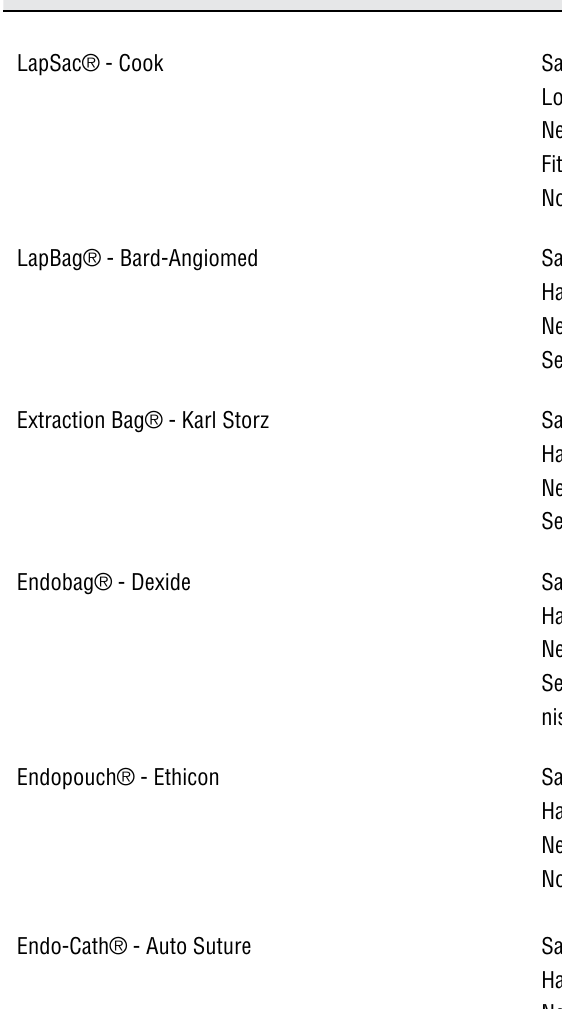
Table 1 - Laparoscopic specimen retrieval devices. Device